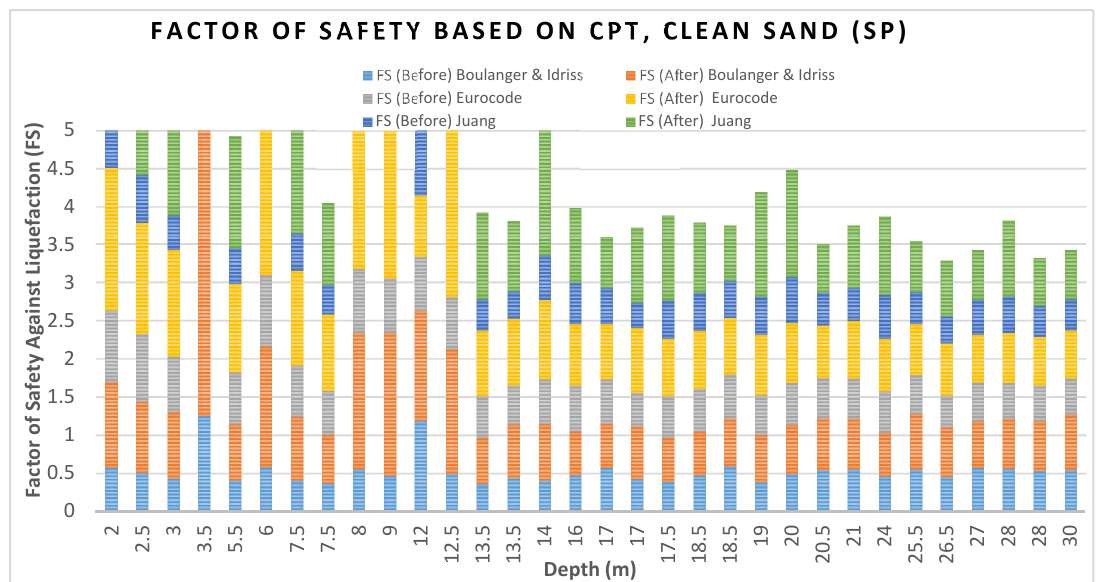
Figure 10. Improvement of the factor of safety against liquefaction triggering based on CPT, before and after jet grouting using micropiles in soil layers containing only poorly graded sand (clean sand).